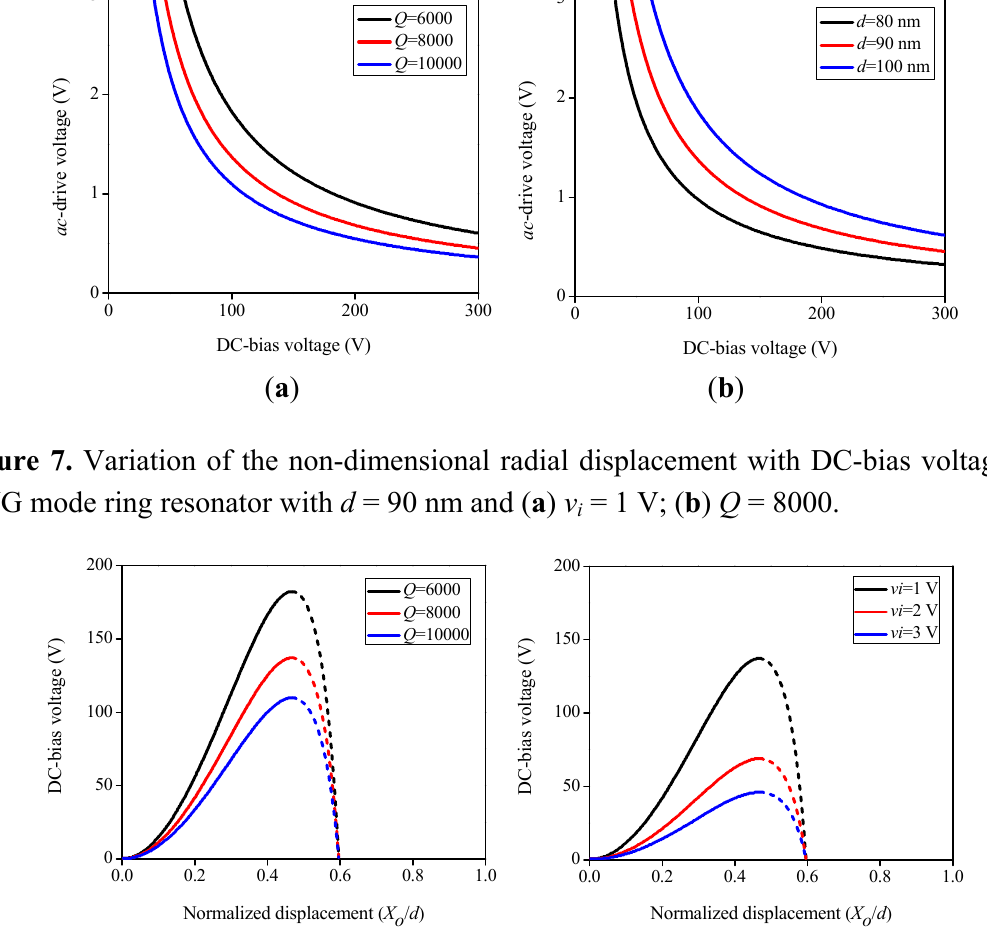
Figure 6. Maximum combinations of ac -drive and DC-bias voltages of EWG mode ring resonator for ( a ) Different values of the quality factor (with d = 90 nm); ( b ) Different values of the gap spacing (with Q = 8000).